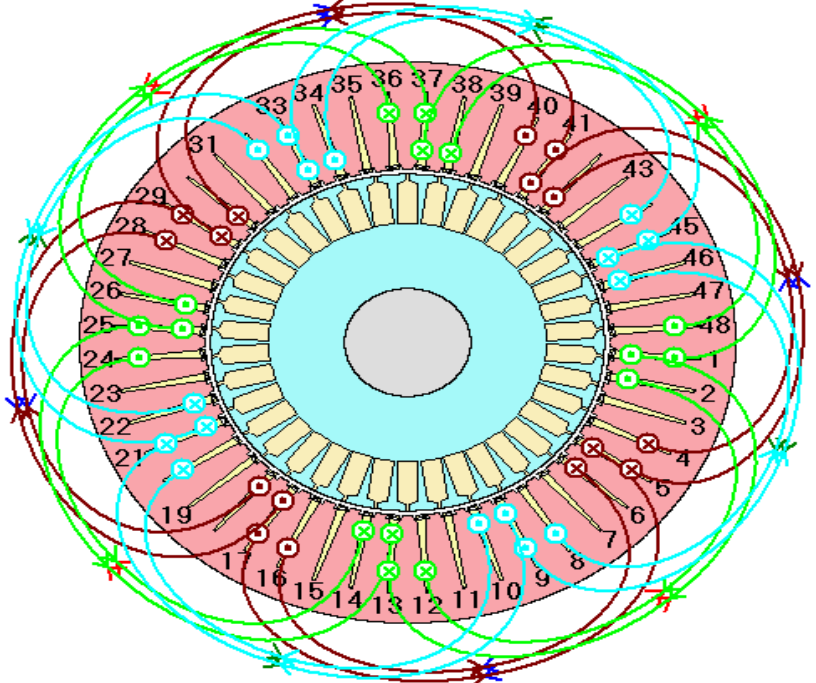
Figure 6. Radial Pattern of the Six Phase Induction Motor Winding.